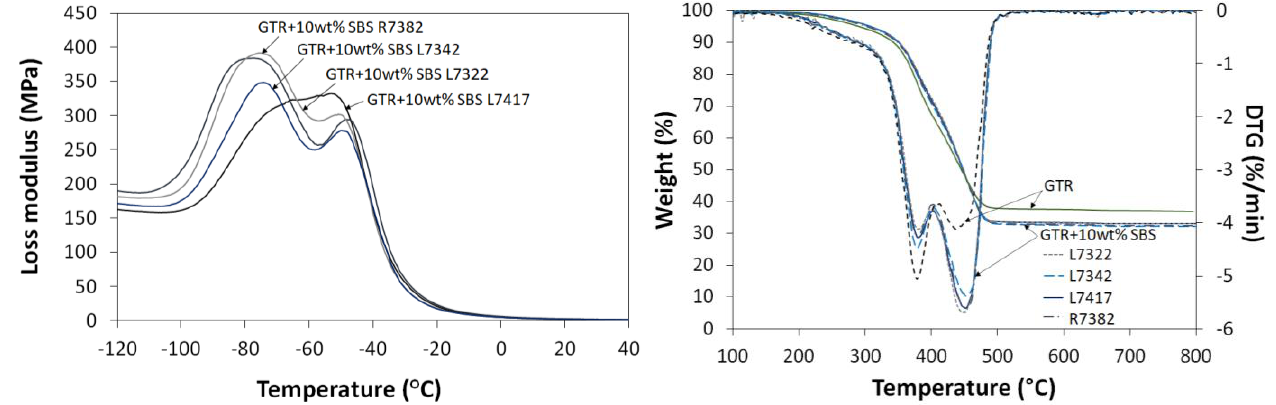
Figure 4. DMA and TGA results for GTR modified by 10 wt% of SBS copolymer as a function of SBS grade.